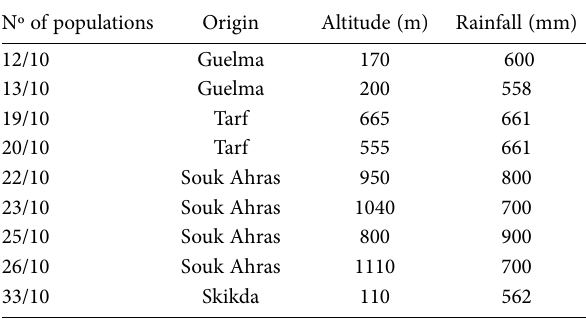
Table 1. Geographical origin and ecological characteristics of the sampling sites of nine populations of Trifolium subterraneum L. in